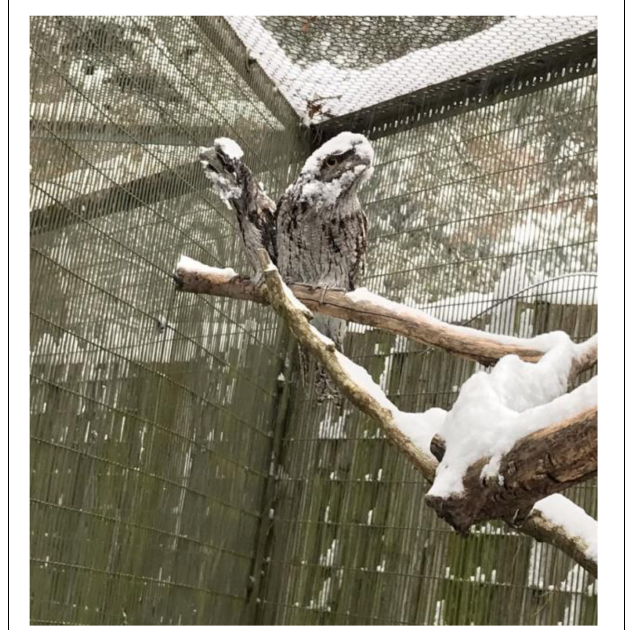
FIGURE 3 | Two captive tawny frogmouths ( Podargus strigoides ) from Woodland Park Zoo in Seattle, Washington after a snowfall